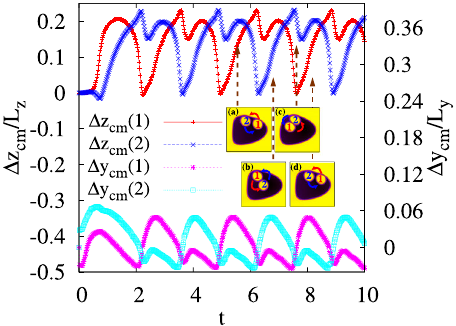
Fig. 5 Time evolution of the displacement Δ z cm and Δ y cm of the cores. On the left axis Δ z cm ( i ) = z cm ( i ) − z cm ( O ) (red/plusses and blue/crosses) and on the right axis Δ y cm ( i ) = y cm ( i ) − y cm ( O ) (pink/asterisk and cyan/ squares) of the two cores. They are calculated with respect to the center of mass of the external droplet. The inset shows the typical trajectories of the cores during a cycle. Red and blue arrows indicate the direction of rotation of droplets 1 and 2, respectively. Snapshots are taken at t = 5.54 × 10 5 ( a ), t = 6.3 × 10 5 ( b ), t = 7.5 × 10 5 ( c ), and t = 8.16 × 10 5 ( d ). Multiplication by a factor 10 5 is understood for the simulation time t on the horizontal axis. This applies to all plots in the paper.